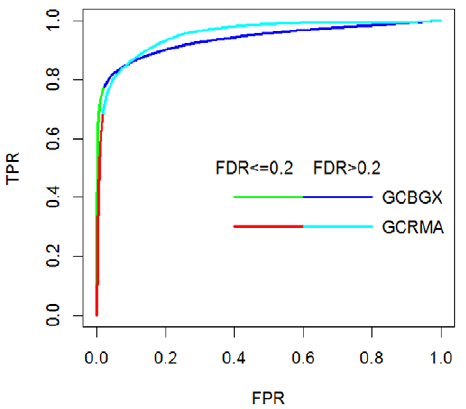
Figure 7. Comparing the ROC curves between the methods GCBGX and GCRMA. The values were averaged over the nine comparisons. Colors in each curve represent FDR levels dichotomized at the cutoff value of 0.2.